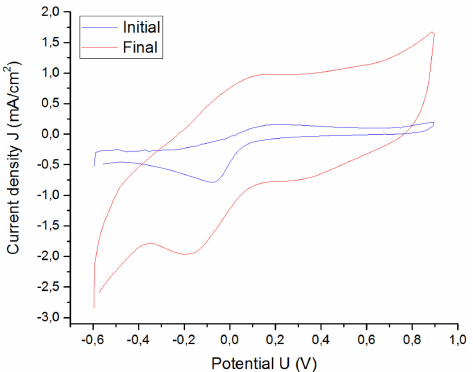
Figure 17. CV of the Pt cu ff electrode G in NaCl at room